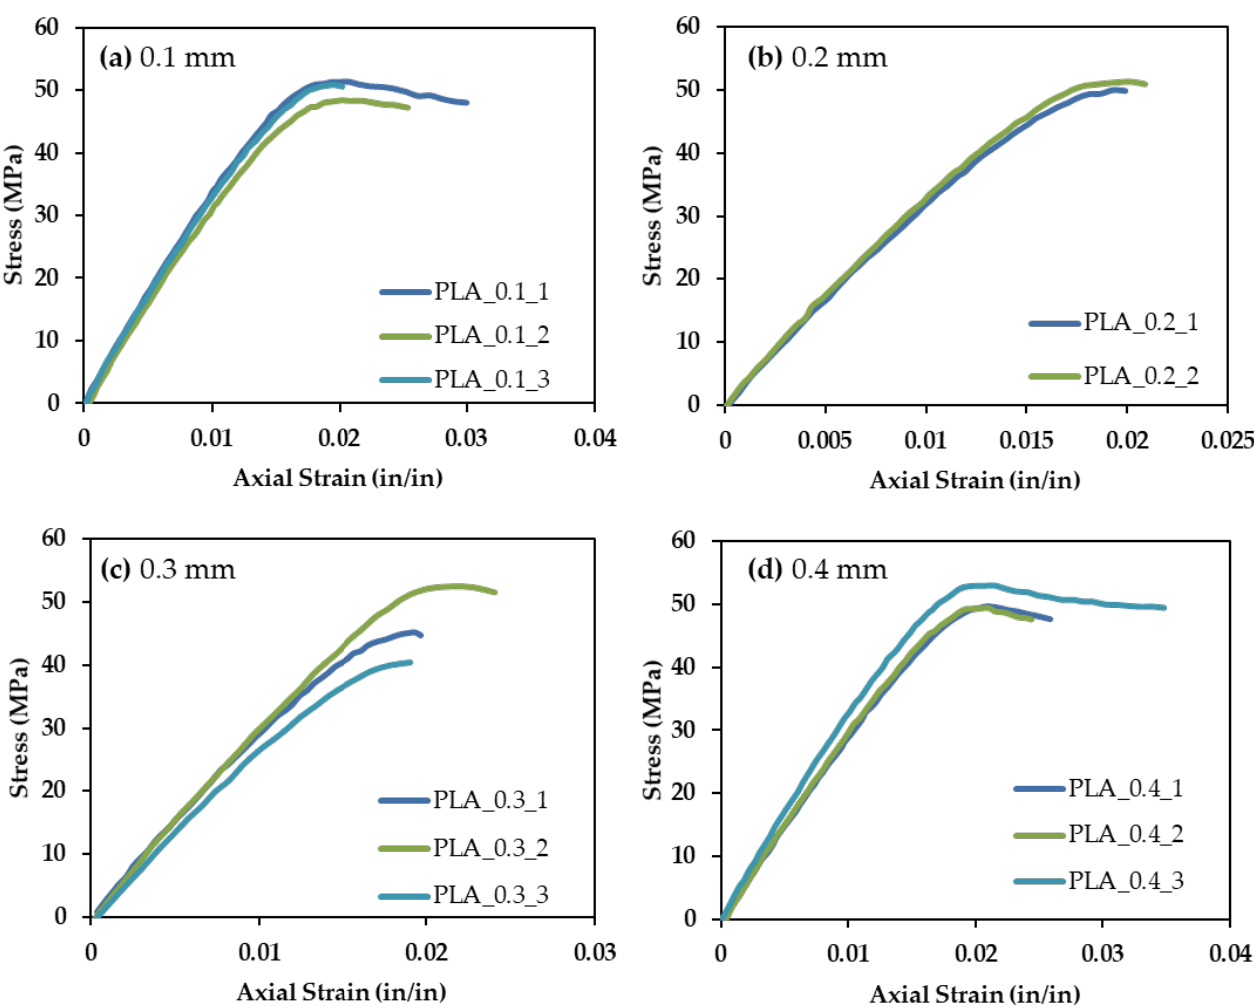
Figure 9. Tensile data for PLA with a print layer height of ( a ) 0.1 mm, ( b ) 0.2 mm, ( c ) 0.3 mm, and ( d ) 0.4 mm.